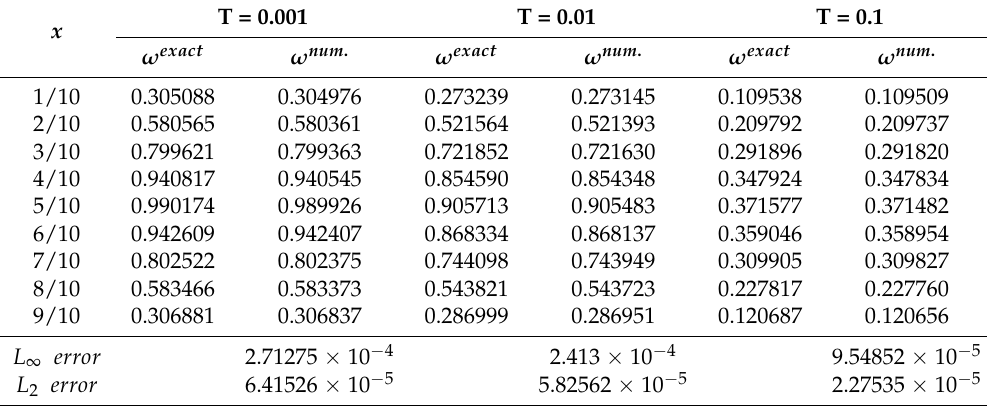
Table 1. Computed results and analytical results at different T with ν d = 2, τ = 0.0001 and ∆ x = 0.0125 for problem 5.1.